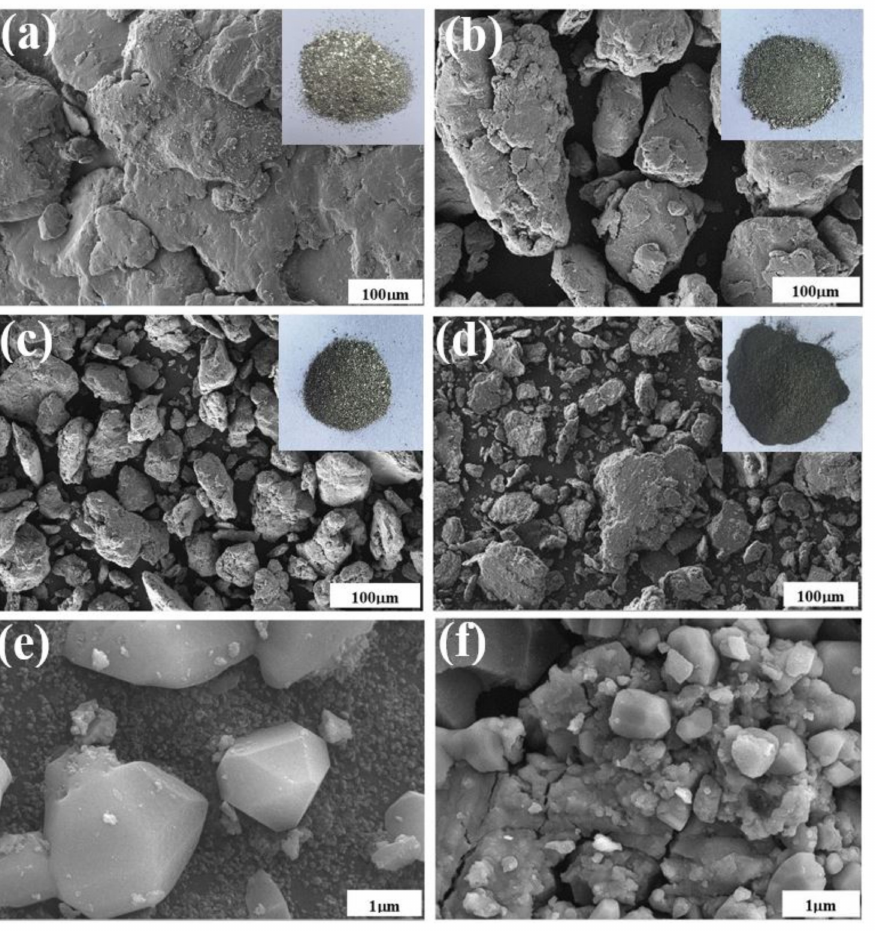
Figure 8. SEM images of milled Mg with insets of camera images ( a ), 95Mg5PKSBC ( b ), 90Mg10PKSBC ( c ), 80Mg20PKSBC ( d ), SEM images of H-milled Mg ( e ), and H80Mg20PKSBC ( f ) prepared at 360 ◦